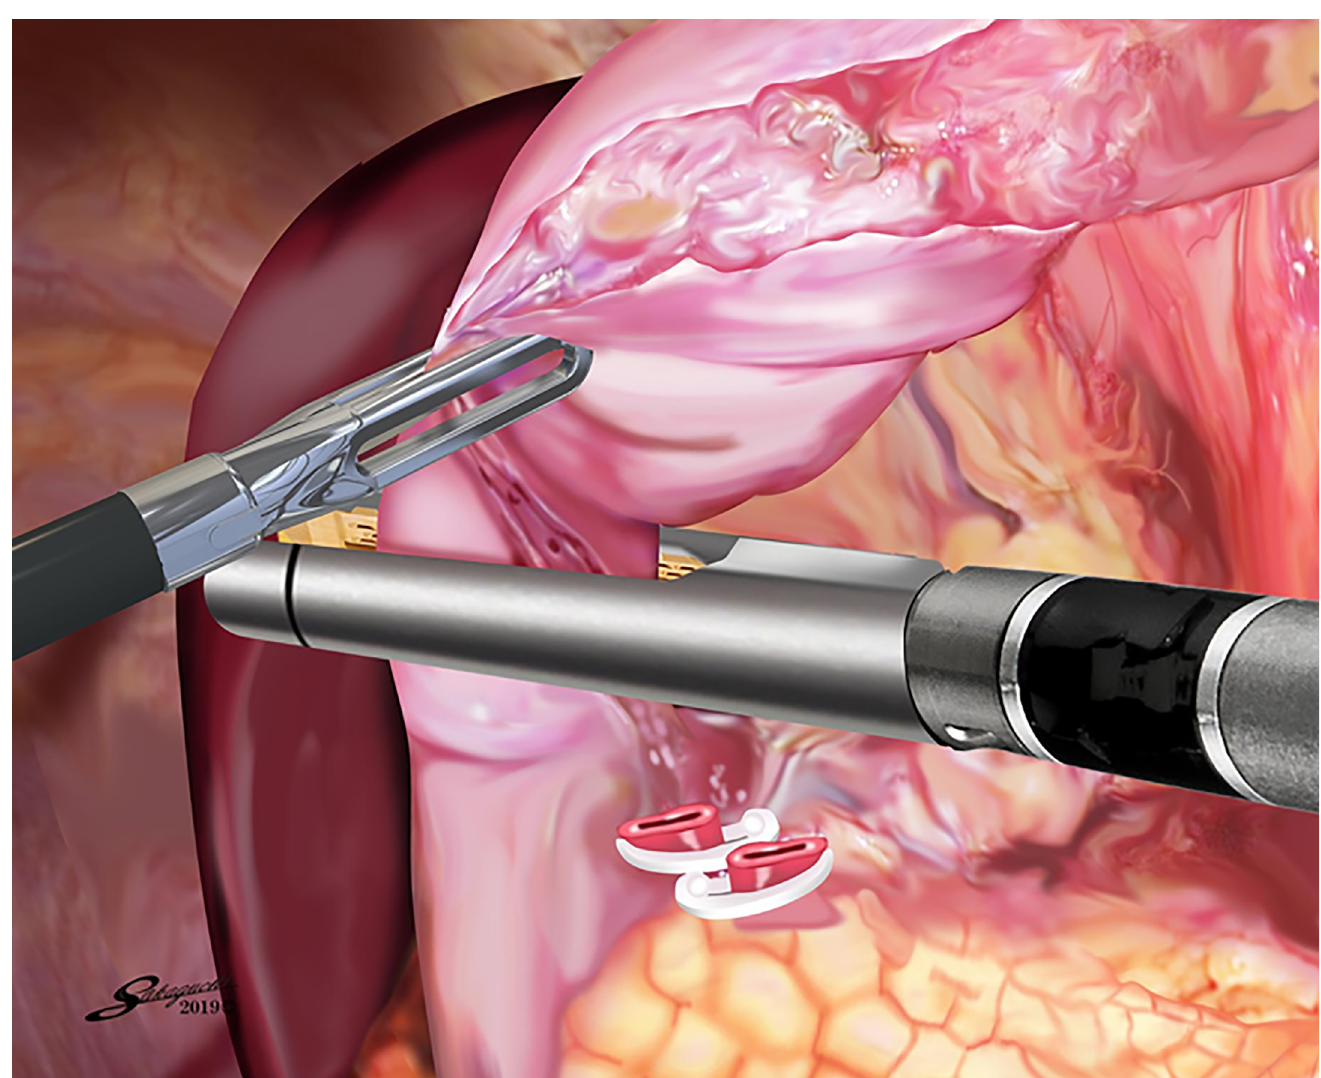
Fig 2. Transection of the duodenal bulb. The operator transects the duodenal bulb using one linear stapler in a posteroanterior direction with the right hand while retracting the greater curvature side of the pyloric ring laterally with the left hand. https://doi.org/10.1371/journal.pone.0230113.g002 toward the ventral side to create a good view of the greater curvature side of the stapler entry hole (Fig 5B), single-layer full-thickness continuous suturing with a 15-cm-long 3–0 V-Loc 180 (VLOCL0604; taper point, 1/2 circle/26 mm; Covidien, Mansfield, MA, USA) was per- formed from the greater curvature side to the lesser curvature side [15]. The first full-thickness stitch was securely placed on the greater curvature side, and the needle was passed through the loop (Fig 5C) [15]. The second and third stitches were made between the seromuscular layer of the remnant stomach and the full-thickness layer of the duodenum, with the duodenal mucosa being sutured as minutely as possible, to avoid extroversion of the mucosa of the alimentary tract near the greater curvature side (Fig 5D–5F) [15]. This single-layer full-thickness continu- ous suturing with the 15-cm-long 3–0 V-Loc 180 was performed until the suture crossed over the knotted 3–0 Prolene suture on the lesser curvature side (Fig 5G) [15]. The suture end was cut simply, as short as possible [15]. Routinely, one or two full-thickness knotted sutures of